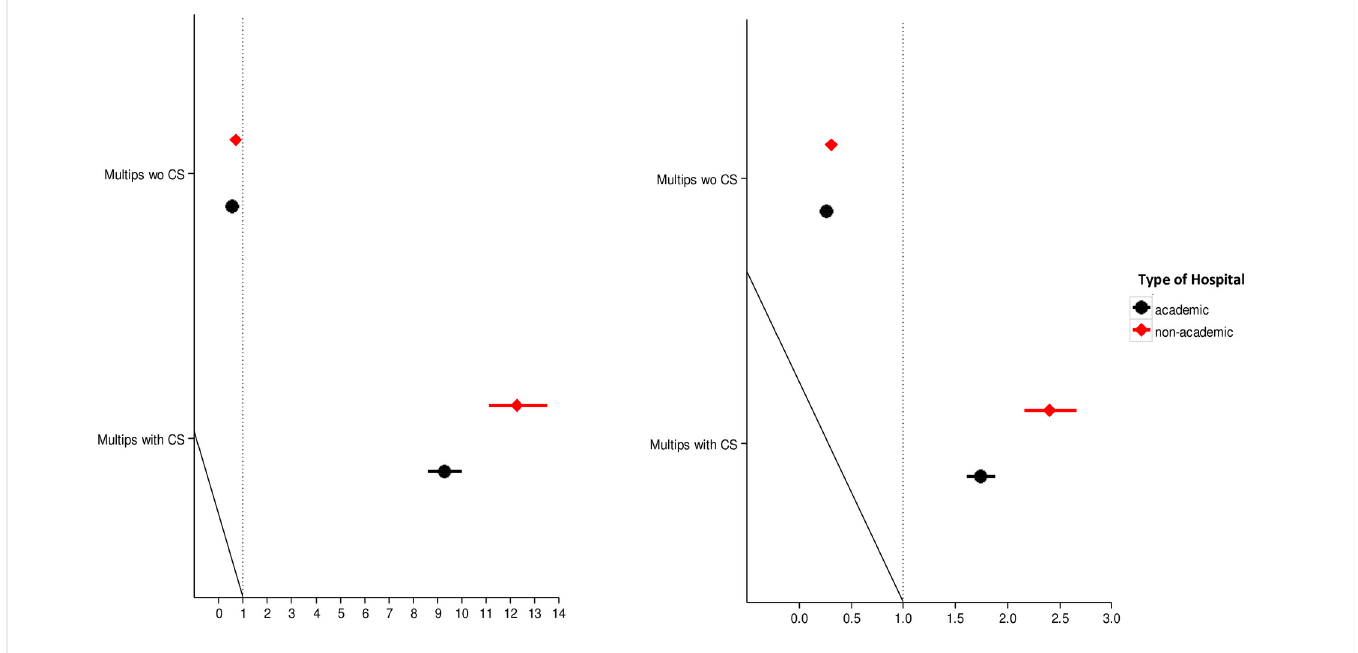
Fig 2. Risk of elective and emergency CS differs for parity groups in academic and non-academic hospitals. CS- caesarean